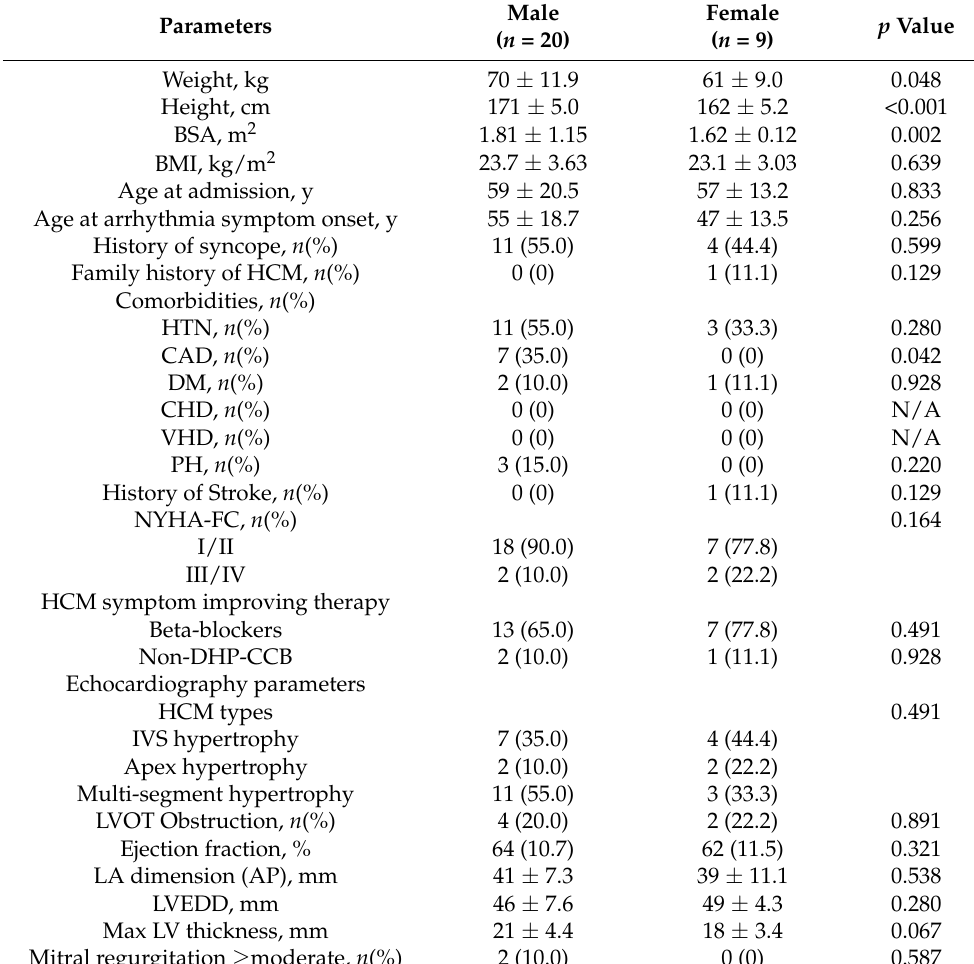
Table 4. Comparisons between male and female